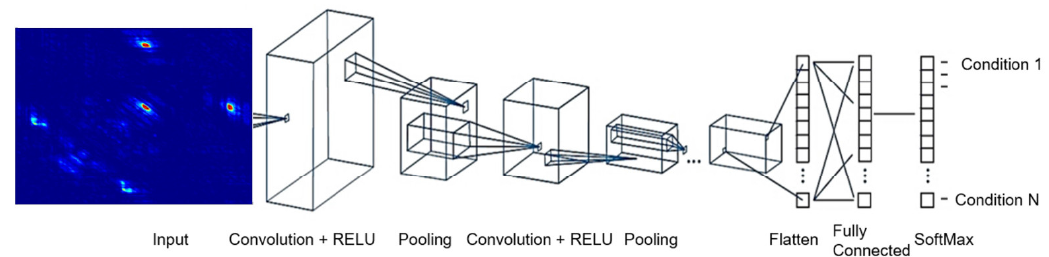
Figure 2. Convolutional neural network.